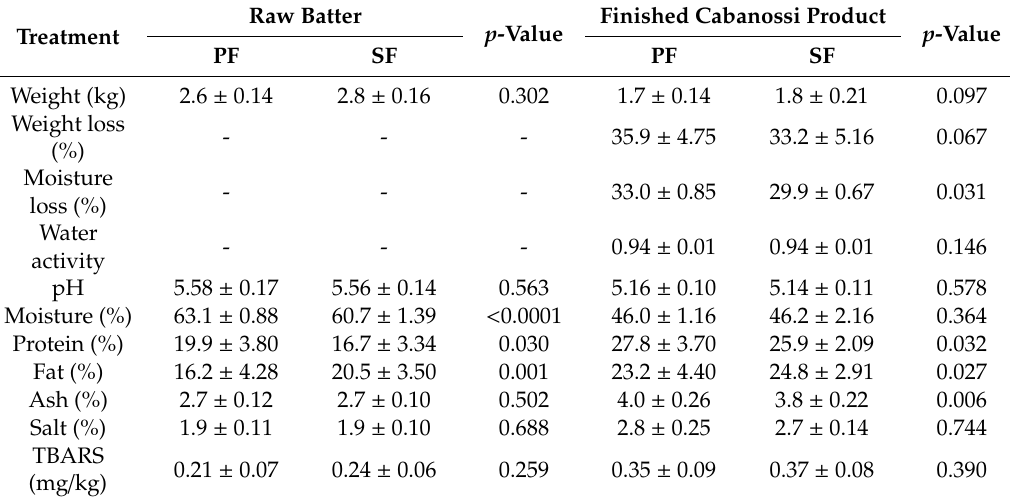
Table 3. Physicochemical attributes and lipid oxidation of raw batter and cabanossi made with either pork backfat (PF) or sheep tail / backfat